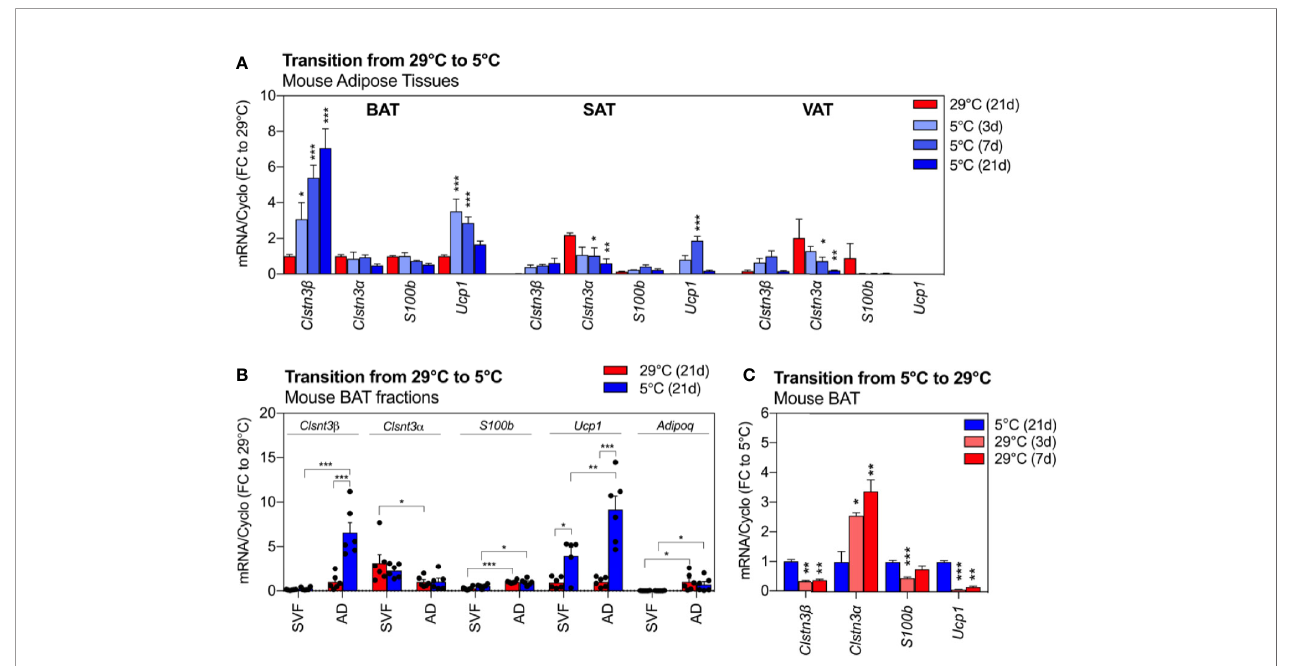
FIGURE 2 | Clsnt3 b is enriched in mouse brown fat and dynamically regulated by temperature in thermogenic adipose depots. (A) Relative gene expression of Clstn3 b , Clsnt3 a , S100b and Ucp1 in mouse BAT, SAT and VAT after chronic exposure to thermoneutrality (29°C, 21 days) and transition to cold (5°C) for 3, 7 or 21 days. Data are expressed relative to BAT at 29°C for each gene. (B) Brown fat fraction enrichment analysis showing gene expression in BAT stromal vascular fraction (SVF) or adipocytes (AD) of mice exposed chronically to thermoneutrality or cold (21 days). Data are expressed relative to adipocyte fraction at 29°C for each gene. (C) Regulation of gene expression in mouse BAT after chronic exposure to cold (5°C, 21 days) and transition to thermoneutrality (29°C) for 3 or 7 days. Data represent means ± SEM and are based on n = 3 – 6 mice per condition. Overall effects of temperature and depot are reported in graphs (two-way-ANOVA in A , B ; one-way-ANOVA in C ) and post-hoc comparisons between groups are indicated by asterisks. Asterisks: *p < 0.05, **p < 0.01, ***p <